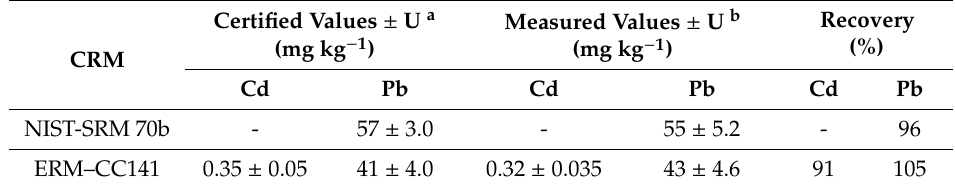
Table 2. Certified values of CRMs, measured values ( n = 6 parallel determinations) and the recoveries degree (%). Recovery Certified Values ± U a Measured Values ± U b (%) (mg kg − 1 ) (mg kg − 1 ) CRM Cd Pb Cd Pb Cd Pb NIST-SRM 70b - 57 ± 3.0